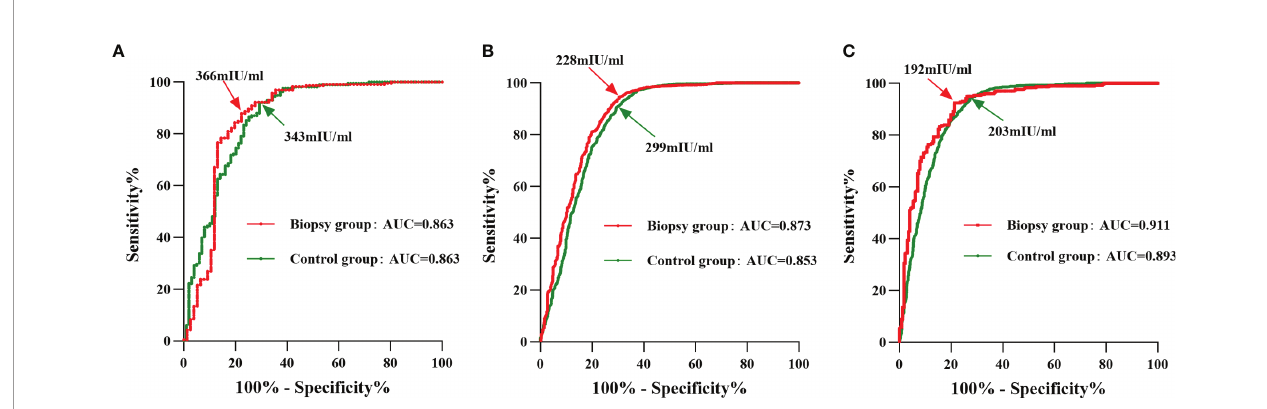
FIGURE 2 | ROC curve analysis of HCG 12 in predicting a live birth as a function of different grades of TE-scored blastocyst transfers. Red line, biopsy group; green line, control group. The points indicated by arrows represent the optimal cutoff values with the highest sum of sensitivity and speci fi city. (A) , grade-A TE score of transferred blastocysts; (B) , grade-B TE score of transferred blastocysts; (C) , grade-C TE score of transferred blastocysts.